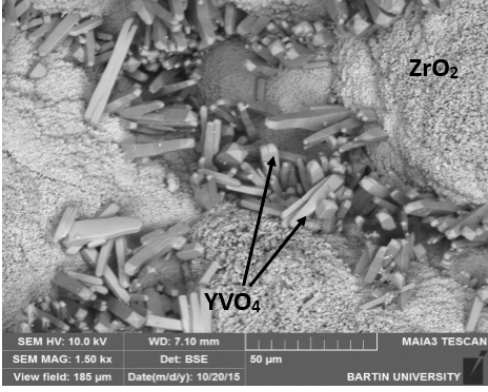
Figure 4. Surface microstructure of TBC after the hot corrosion test.